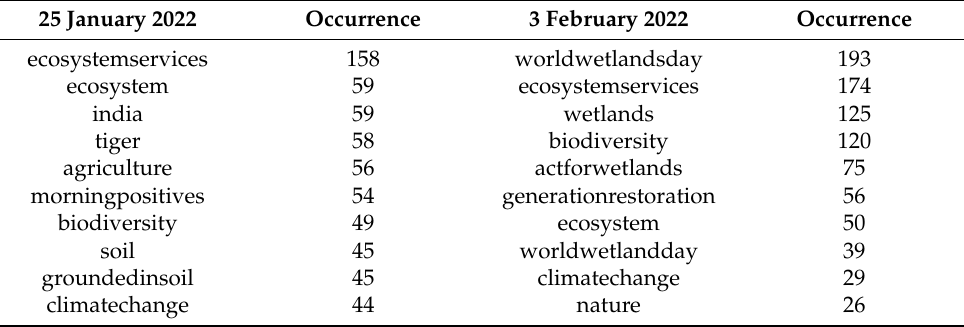
Table 4. Top ten hashtags on tweet about ecosystem services.